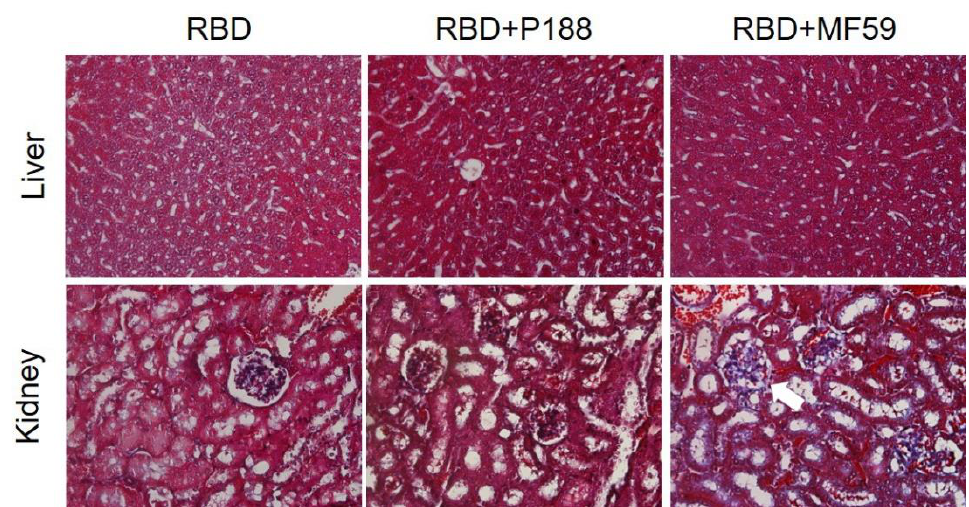
Figure 8. Evaluation of P188 toxicity on liver and kidney of RBD-vaccinated mice. Trichrome staining presented in liver and renal cortex sections of PBS; RBD-vaccinated mice (RBD); RBD plus MF59-vaccinated mice (RBD+MF59); and RBD plus poloxmer188-vaccinated mice (RBD+P188).